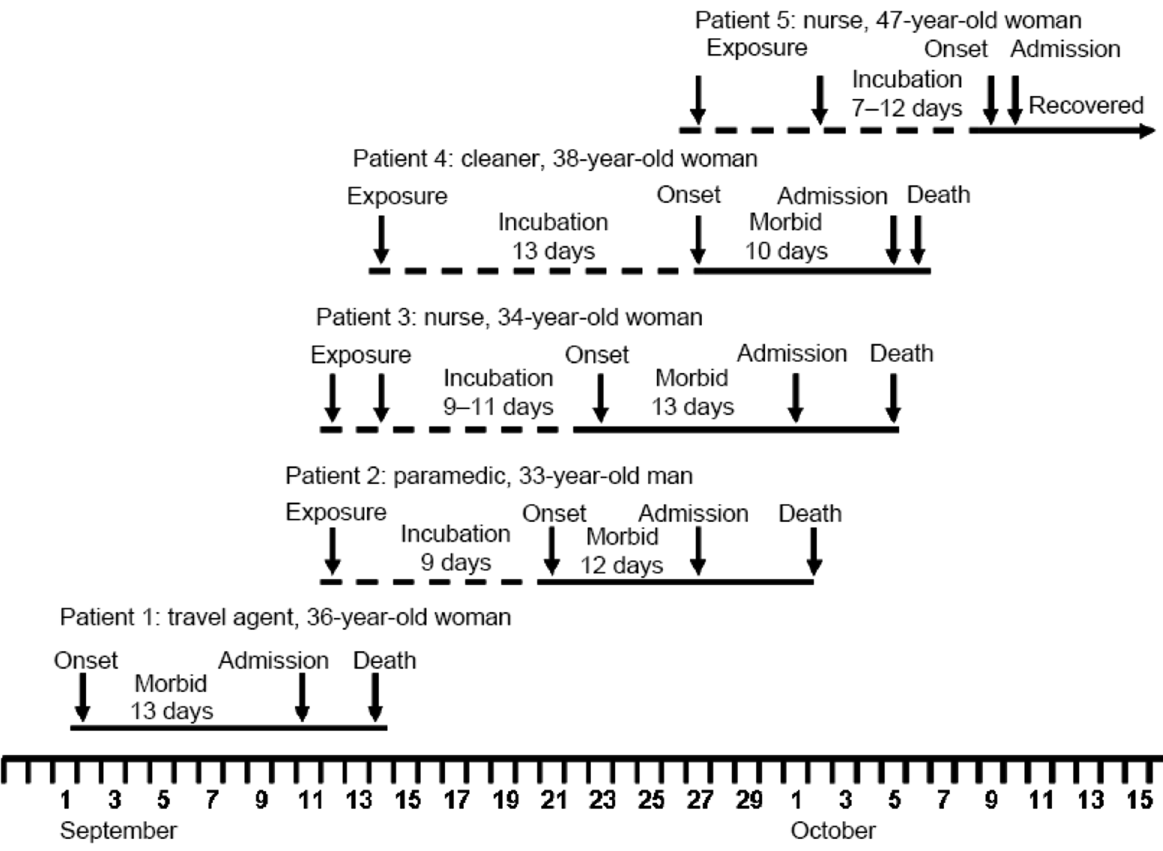
Figure 1. Timeline graph depiction of outbreak.